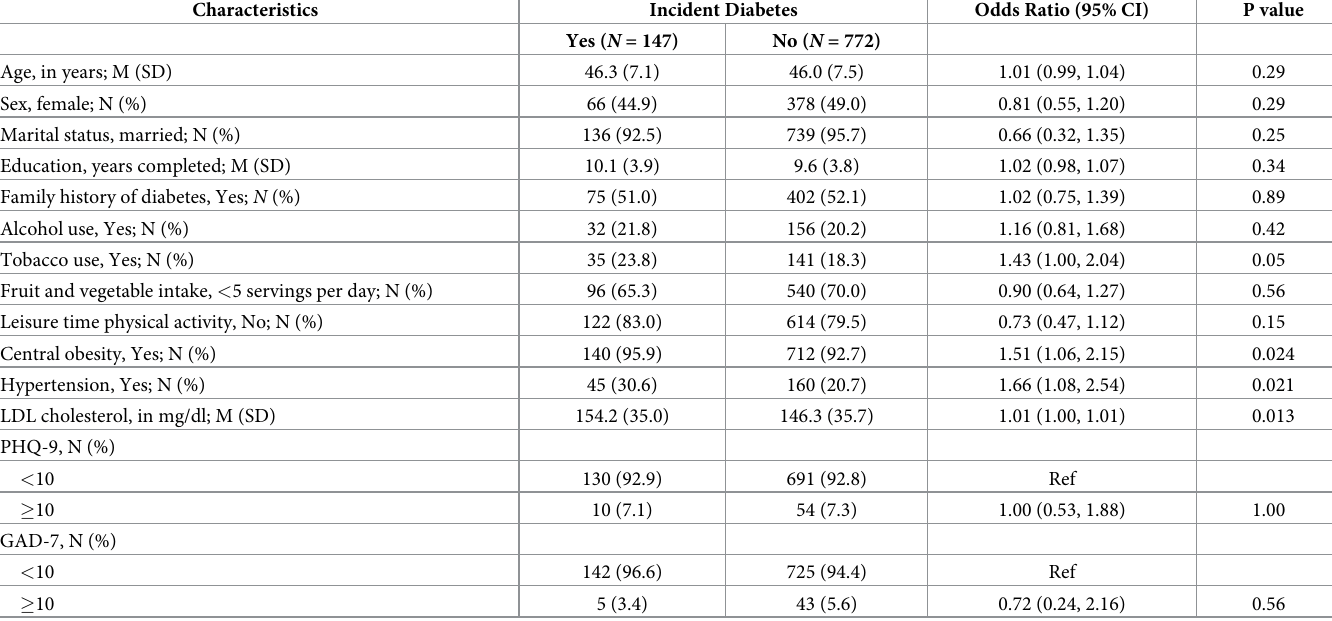
Table 1. Baseline characteristics of K-DPP participants according to incident diabetes at 2 years.